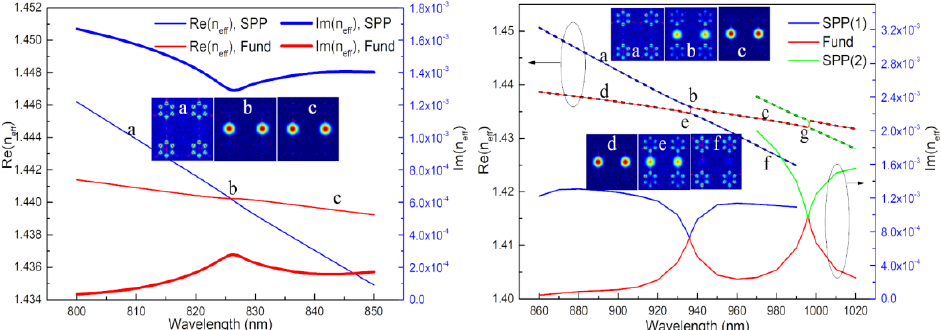
Figure 2. ( Left ): Dispersion relationship between the fundamental mode and the surface plasmon polaritons (SPP) mode with n = 1.46; ( Right ): Dispersion relationship between the fundamental mode and the SPP mode with n = 1.49.